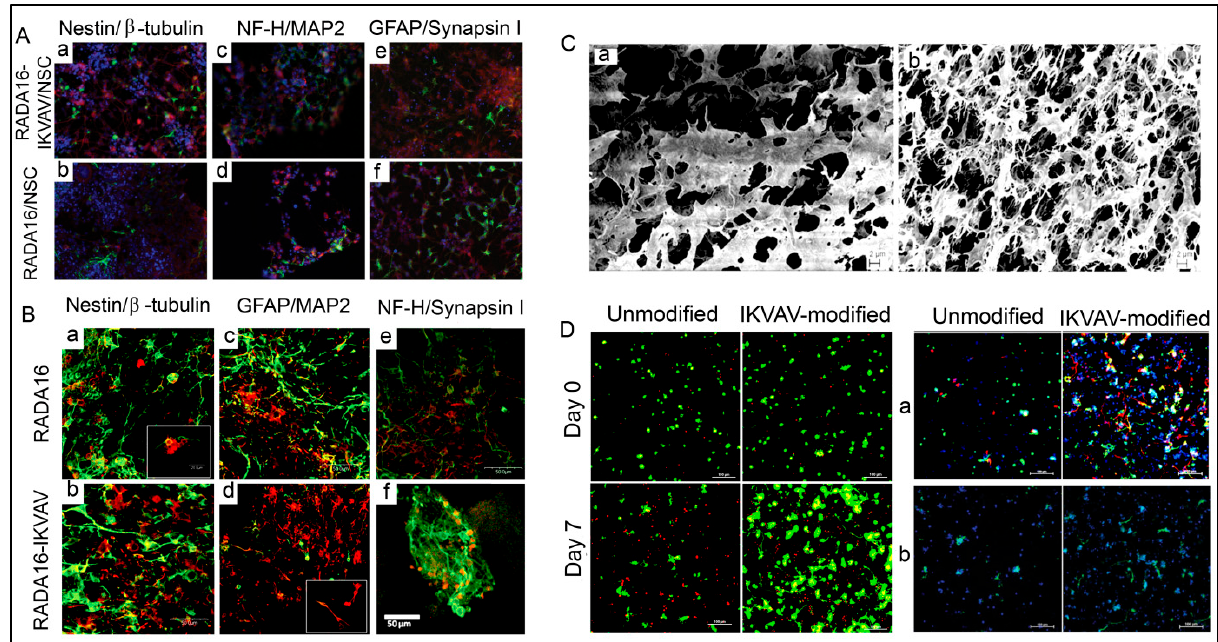
Figure 10. NSCs encapsulation in hydrogel for brain tissue regeneration. ( A ) Immunohistochemis- try of the damaged brain tissues at six weeks after transplantation staining of Nesttin/ β -tubulin